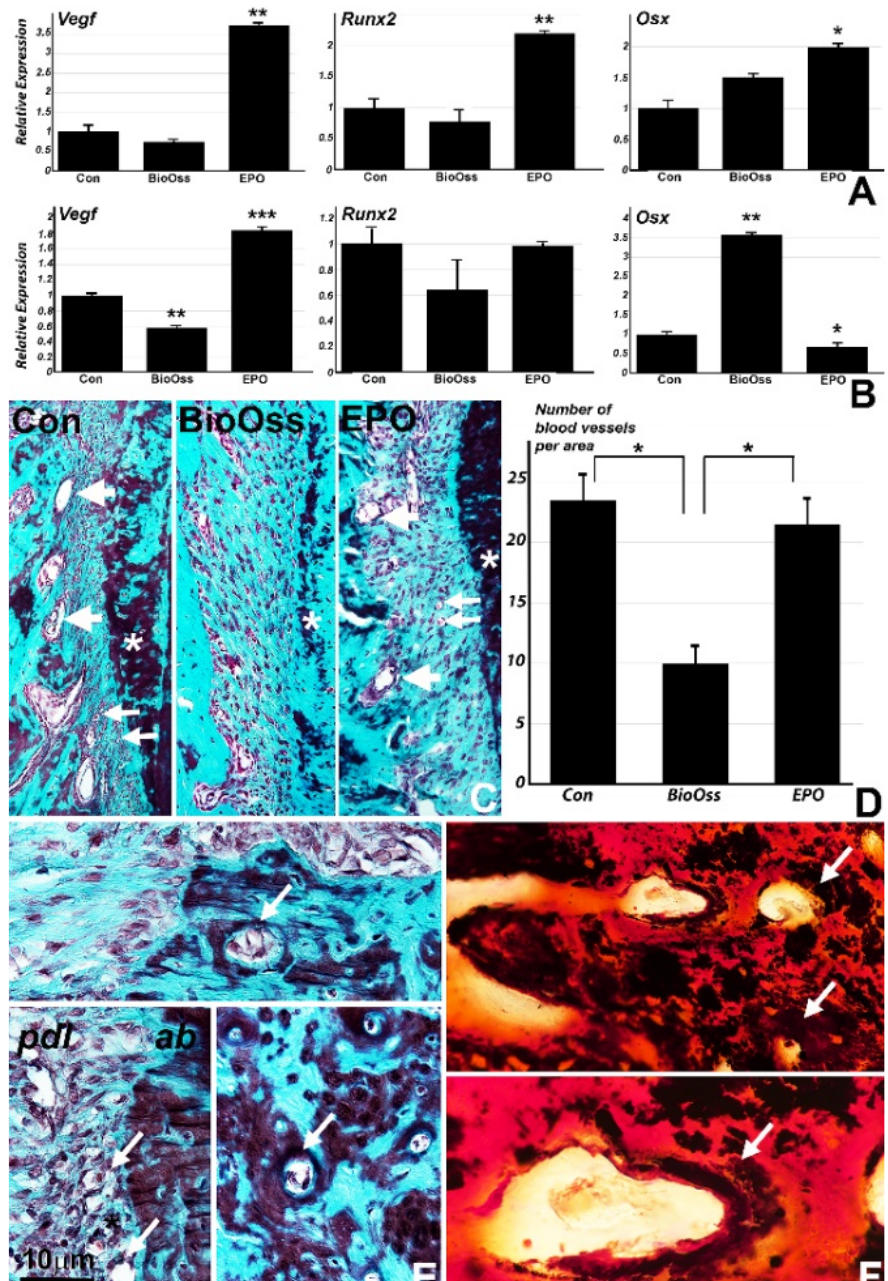
Figure 3. ( A , B ) Effect of collagen membrane, BioOss, and collagen/EPO scaffolds on the expression of key angiogenesis/osteogenesis genes four weeks after surgery ( A ) and 8 weeks after surgery ( B ). Note the significant effect of the collagen/EPO scaffold on Vegf and on the osteoblast transcription factors Osx and Runx2 ( A ). The significance value of p < 0.05 is indicated by *, p < 0.01 is indicated by ** and p < 0.001 is indicated by ***. There was a distinct presence of newly formed capillaries in the collagen/EPO treatment group when compared to the BioOss treatment group ( C , D ). E and F document a close proximity of the newly mineralized bone and blood vessels (small arrows) in the EPO treatment group as illustrated by trichrome stain ( E ) and von Kossa staining ( F